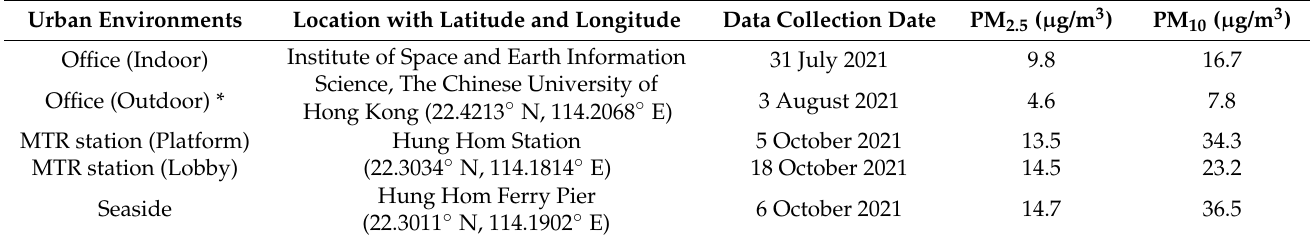
Table 1. The selected environments and dates for data